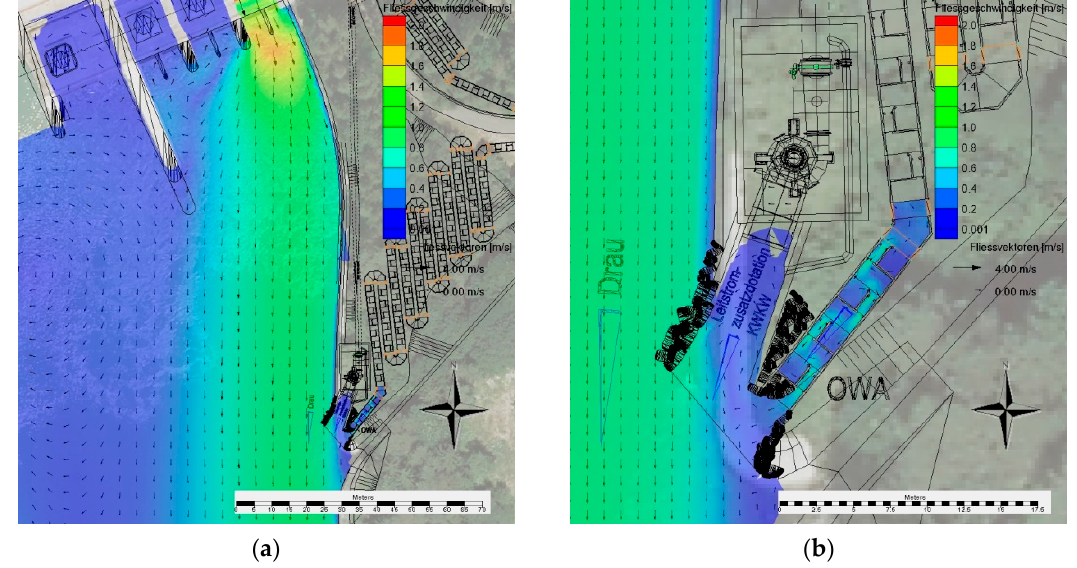
Figure 8. Alternative 3, result overview ( a ) and detail at entrance ( b ) of the 2D model. Q Drava = 135 m 3 / s, Q fish pass = 0.38 m 3 / s + Q attraction flow = 0.97 m 3 / s; competing flow 1%.